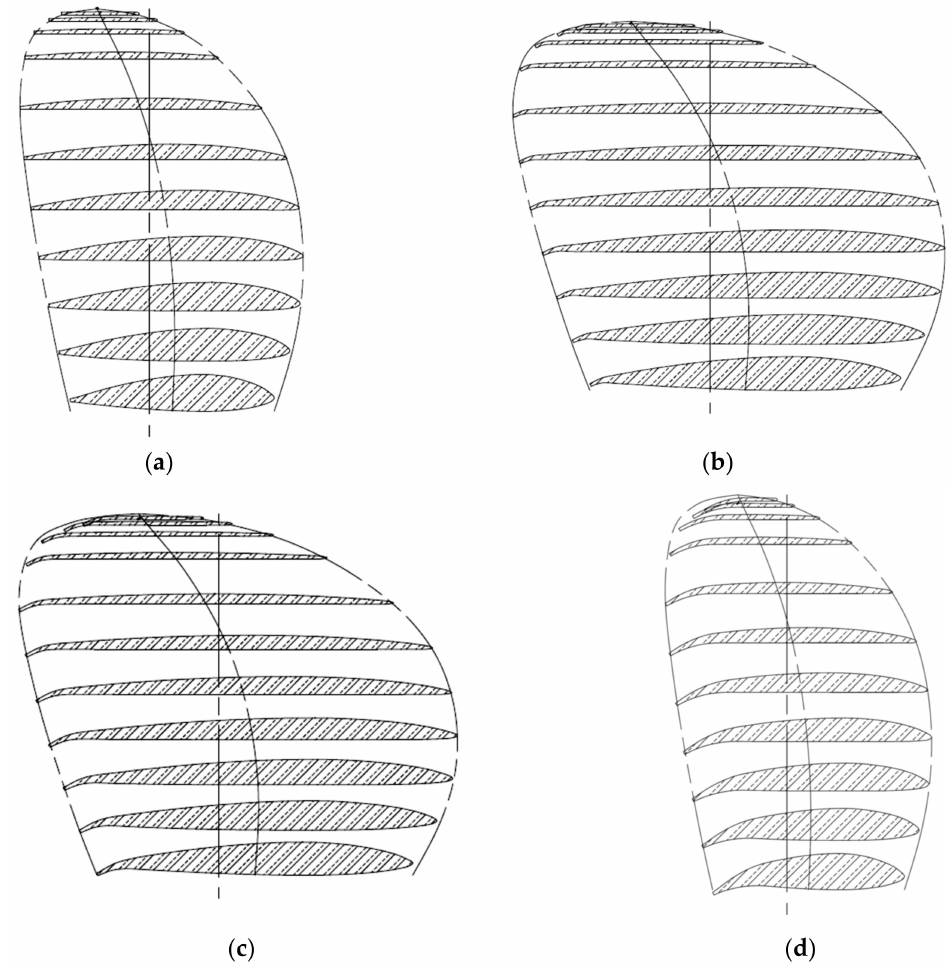
Figure 6. Expanded view of the optimized propeller. ( a ) No cup, ( b ) Light cup, ( c ) Medium cup, ( d ) Heavy